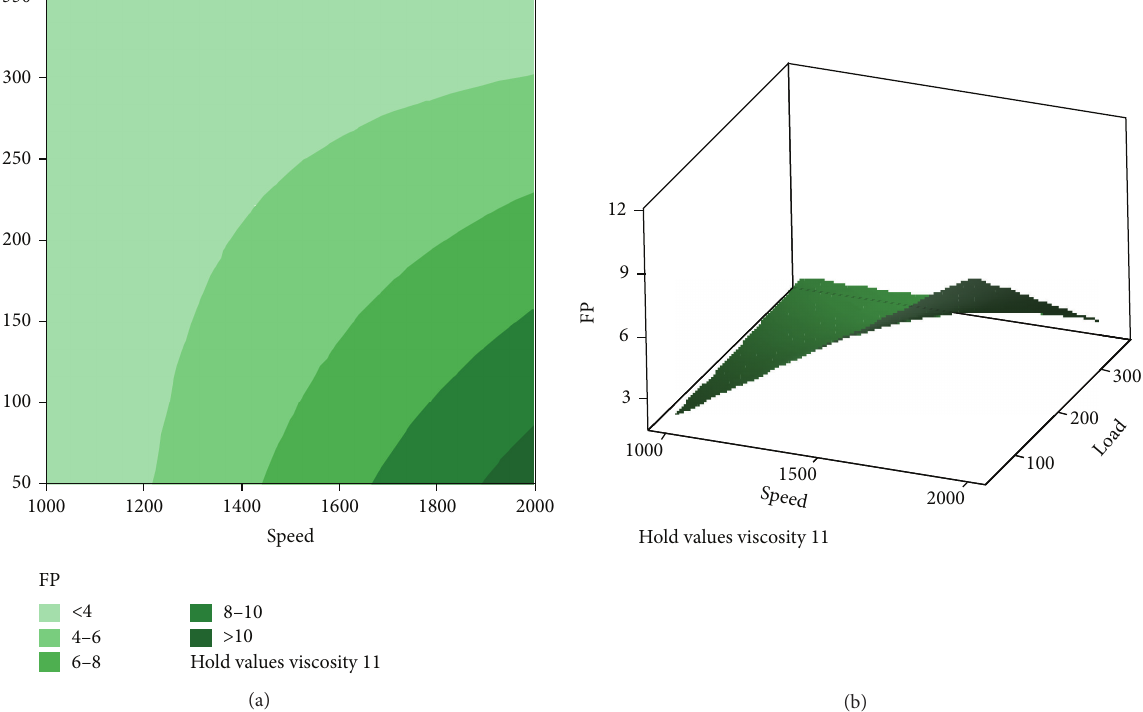
Figure 8: (a) Contour plot of FP versus load and speed at a viscosity of 11cSt. (b) Response surface plot of FP versus load and speed at a viscosity of 11cSt.